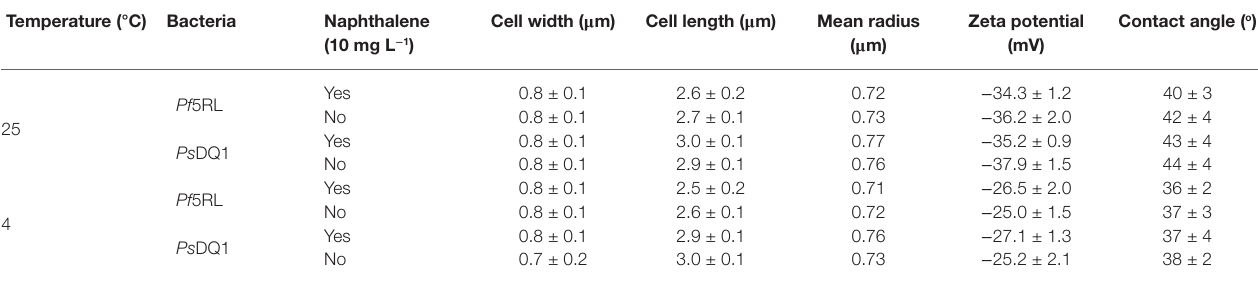
TABLE 1 | Cell width, cell length, mean radius, zeta potential, and contact angle of bacteria at 25°C and 4°C ( n ≥ 50). Temperature (°C) Bacteria